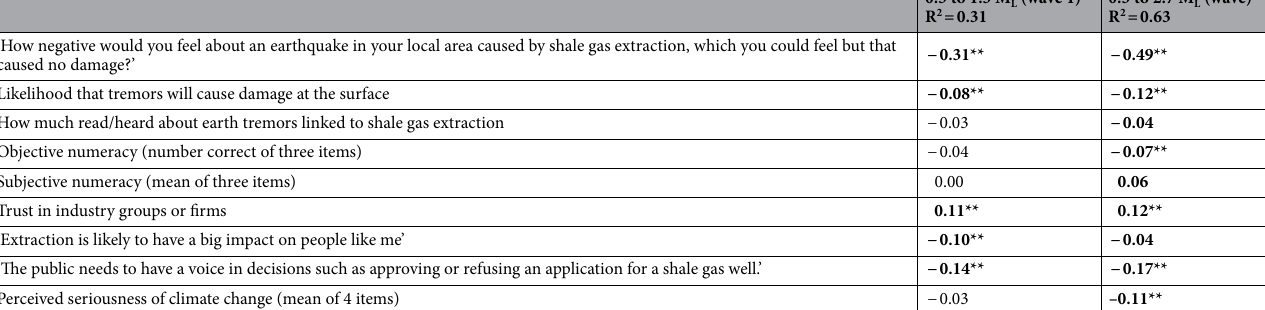
Table 3. Factors predicting support for changing the limit of seismicity allowed for shale gas extraction (linear regressions). NB: Numbers in the cells are standardised beta coefficients. A positive coefficient indicates the variable associates with increased support for the policy change. Bold coefficients are statistically significant at p < 0.05. With one asterisk (*), p < 0.01; with two asterisks (**), p < 0.001. Independent variables